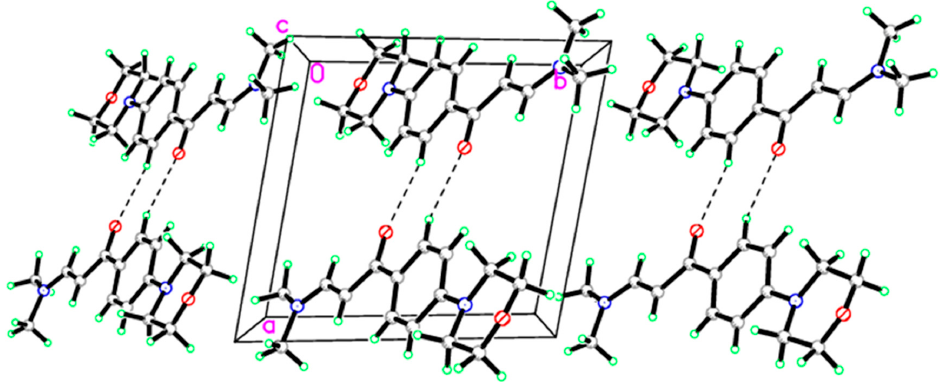
Figure 4. Molecular packing of enaminone ( IIb ) viewed hydrogen bonds which are drawn as dashed lines along a axis.